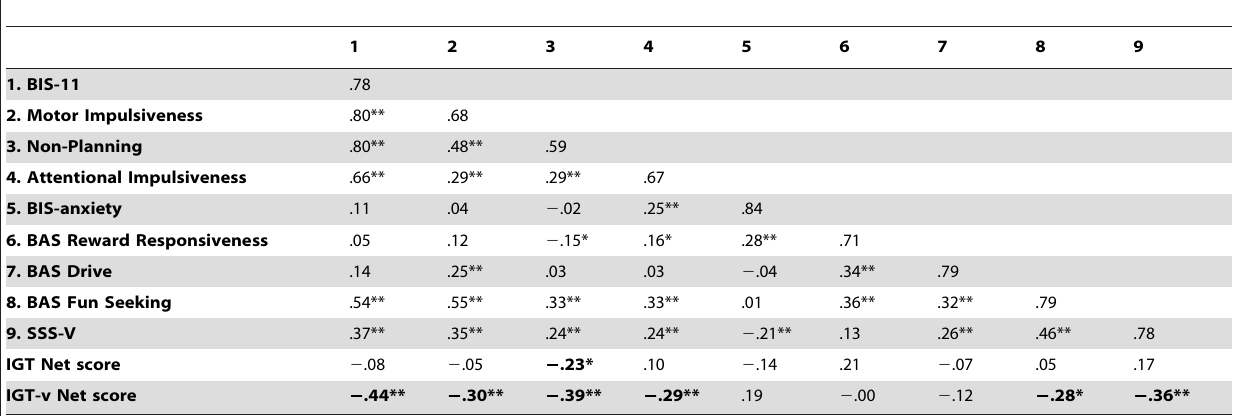
Table 2. Pearson correlation coefficients between self-report and behavioural variables.